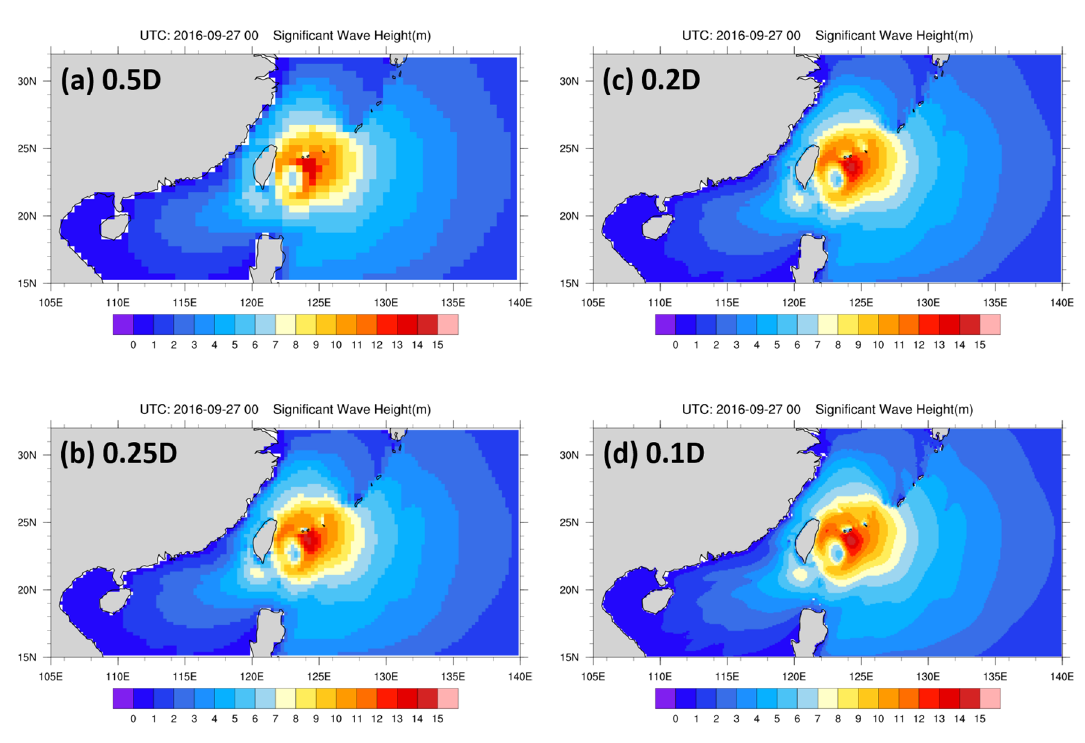
Figure 9. Spatial distribution of Typhoon Megi significant wave height driven by CFSv2 using the WW3 model with ( a ) 0.50 deg, ( b ) 0.25 deg, ( c ) 0.20 deg, and ( d ) 0.10 deg grid resolutions.